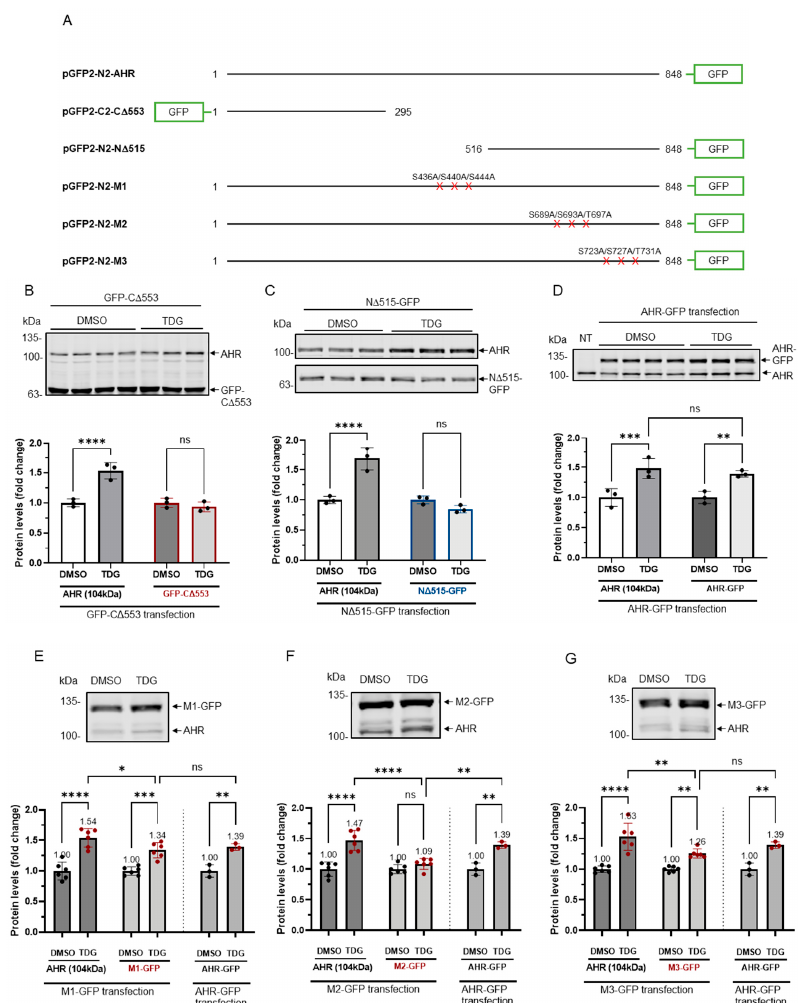
Figure 5. Site-directed mutagenesis reveals three putative GSK3 β phosphorylation sites of AHR. ( A ) A map showing GFP fusion expressing plasmids of full length human AHR and two truncated derivatives (pGFP2-N2-AHR, pGFP2-C2-C Δ 553, and pGFP2-N2-N Δ 515) and three AHR mutant GFP plasmids (S436A-S440A-S444A, M1; S689A-S693A-T697A, M2; S723A- S727A-T731A, M3). The names of the plasmid expressing the corresponding protein are listed on the left. Both GFP fusions of C Δ 553 ( B ) and N Δ 515 ( C ), 56 h after transient transfection, did not respond to TDG while the full-length AHR-GFP after transiently transfecting pGFP2-N2-AHR plasmid for 56 h ( D ) showed similar increase as the endogenous AHR proteins